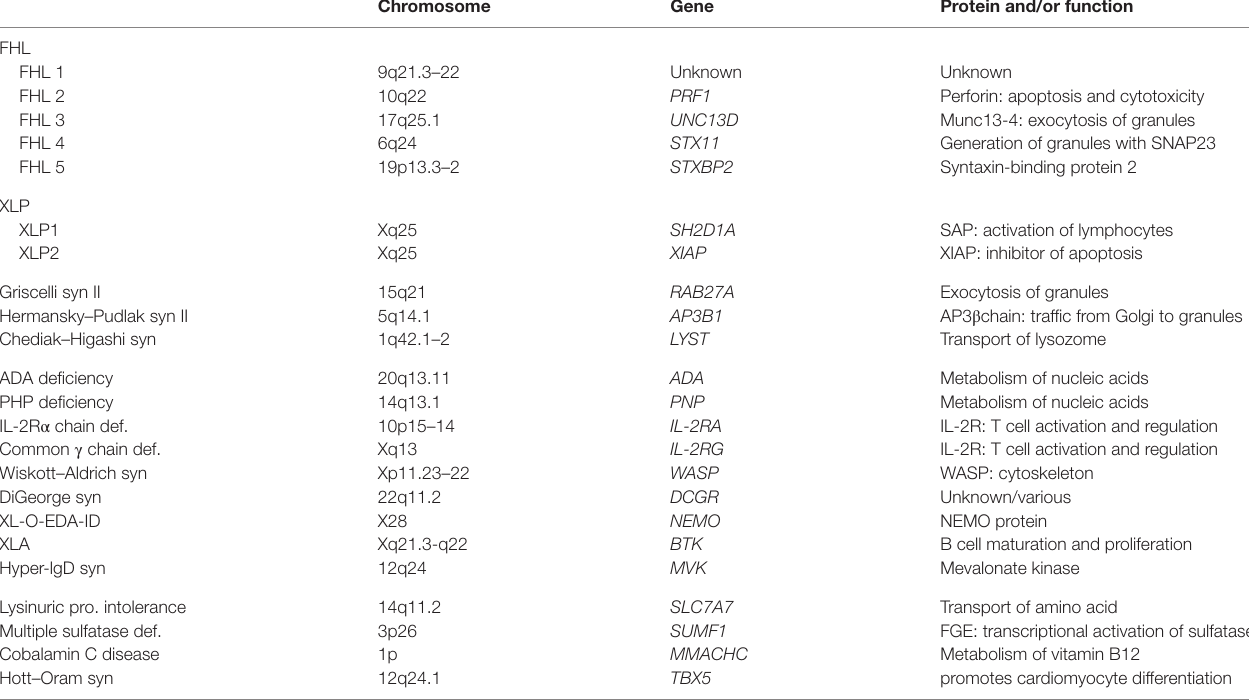
TABLe 2 | Gene mutations associated with primary